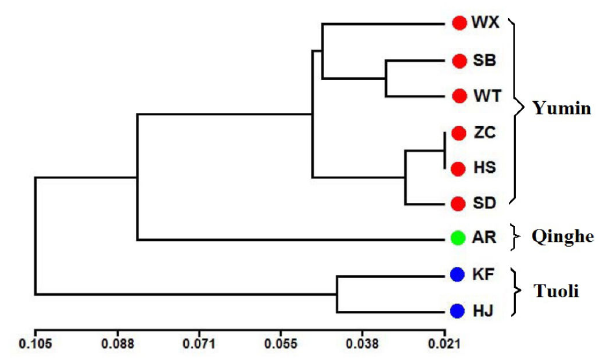
Figure 3. UPGMA dendrogram of the nine populations of P. eryngii var. tuoliensis based on Nei’s genetic distance. The scale bar means the genetic distance. doi: